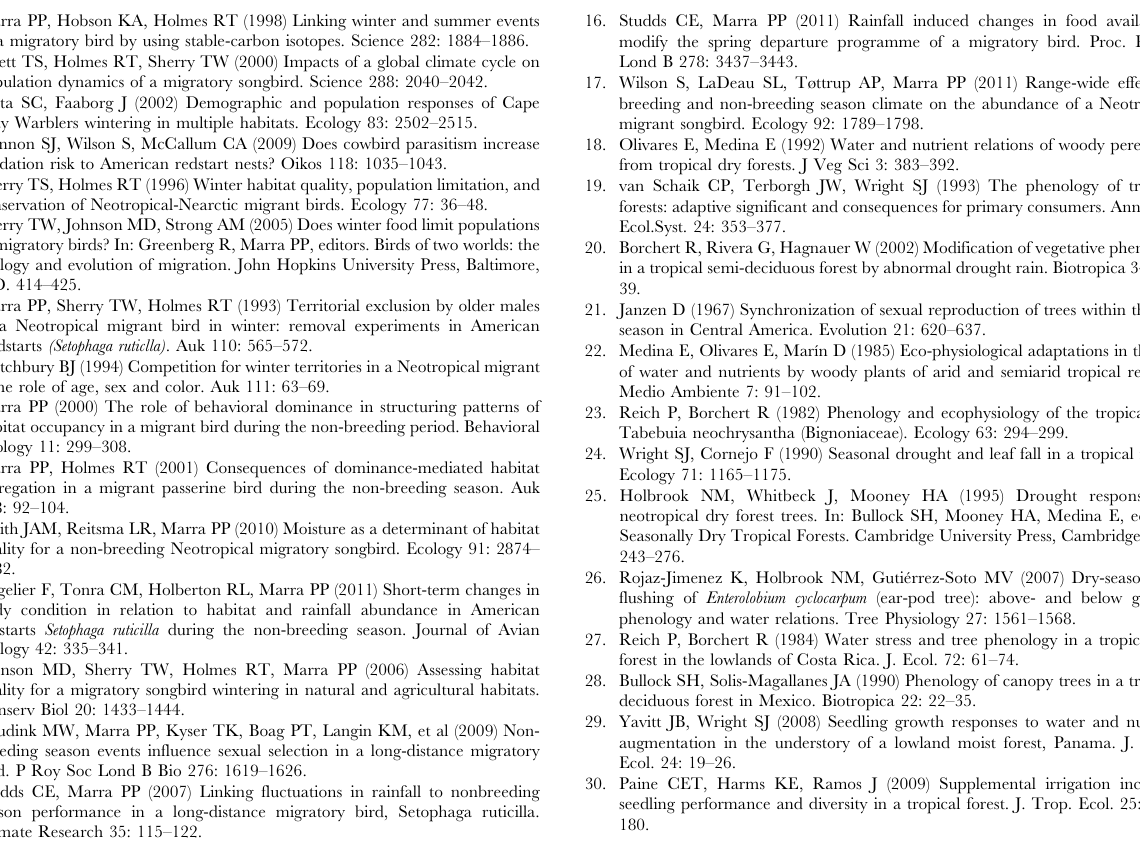
Table S1 Canopy arthropod abundance by group on control and irrigation plots. Early season refers to the period in late January/early February before irrigation, while late season refers to the period in late March/early April after irrigation had ended. Only the more commonly represented groups are shown here. Values are the sample mean mass (g) plus standard error